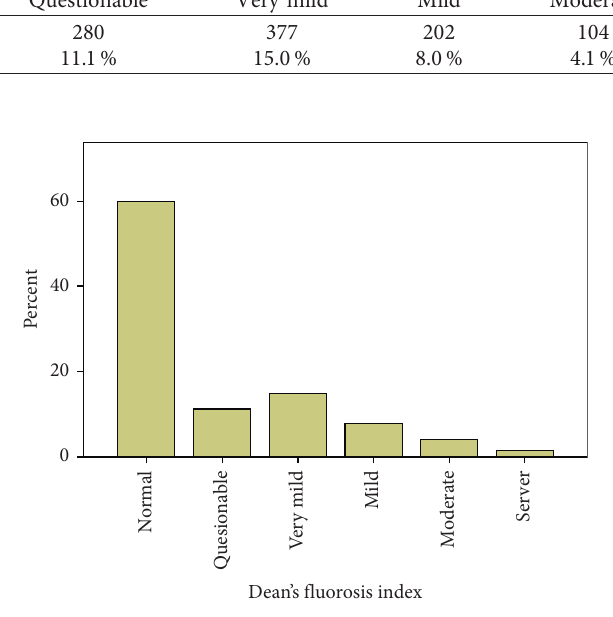
Figure 2: Distribution of fluorosis according to the Dean’s Fluorosis